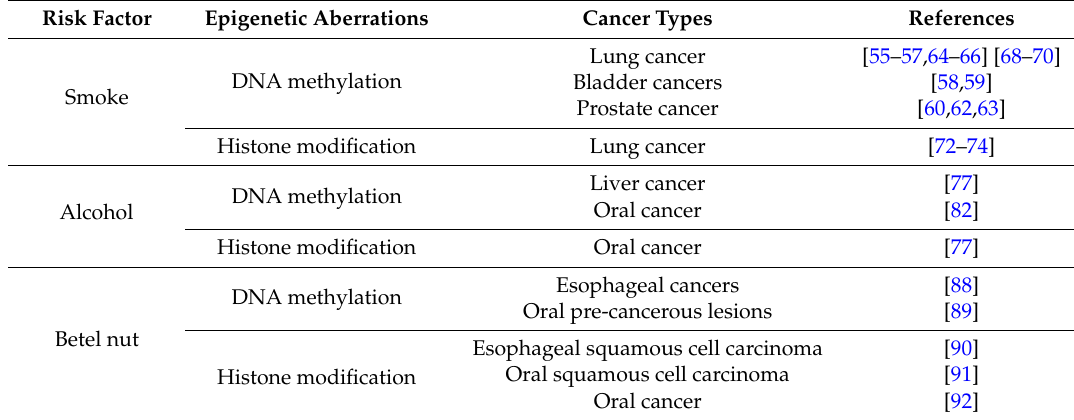
Table 2. Risk factors that induce epigenetic aberrations in various cancer